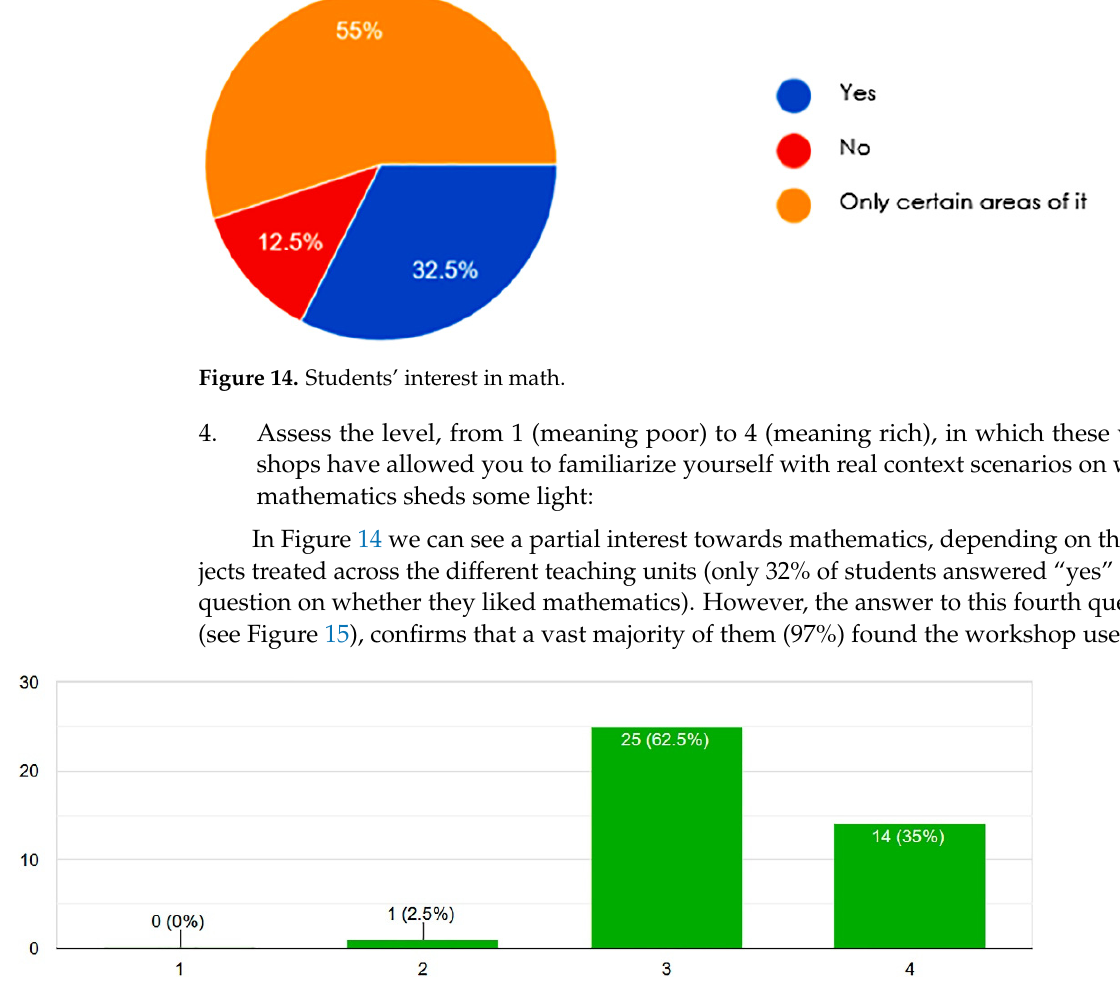
Figure 15. Results of these workshops.